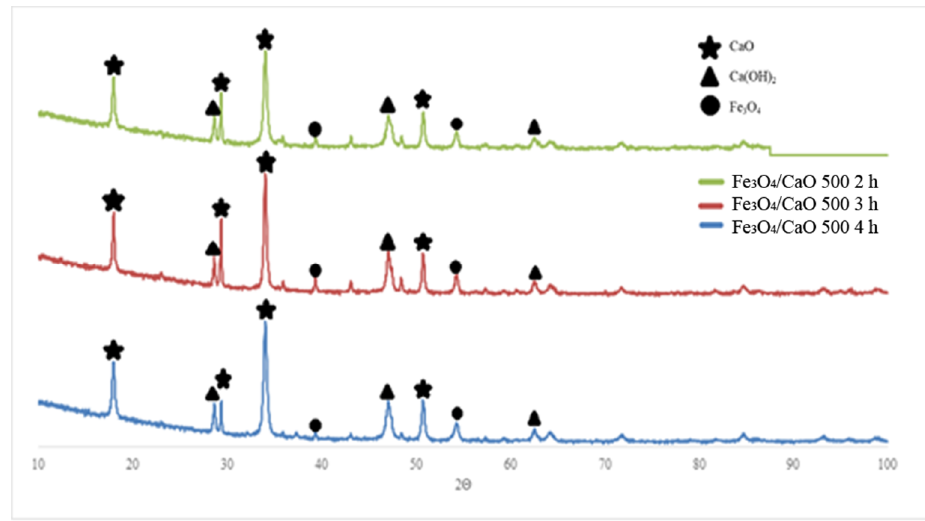
Figure 1. XRD pattern of obtained Fe 3 O 4 /CaO catalyst at a dehydration temperature of 500 °C with various dehydration times of 2 h, 3 h, and 4 h, respectively.